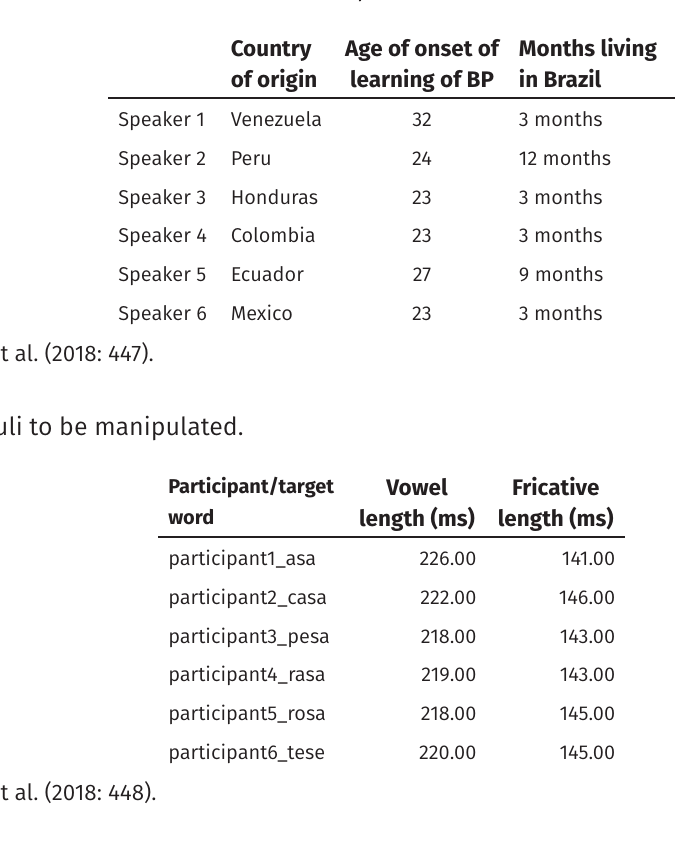
Table 1: Information on the BP Learners (L1: Spanish).